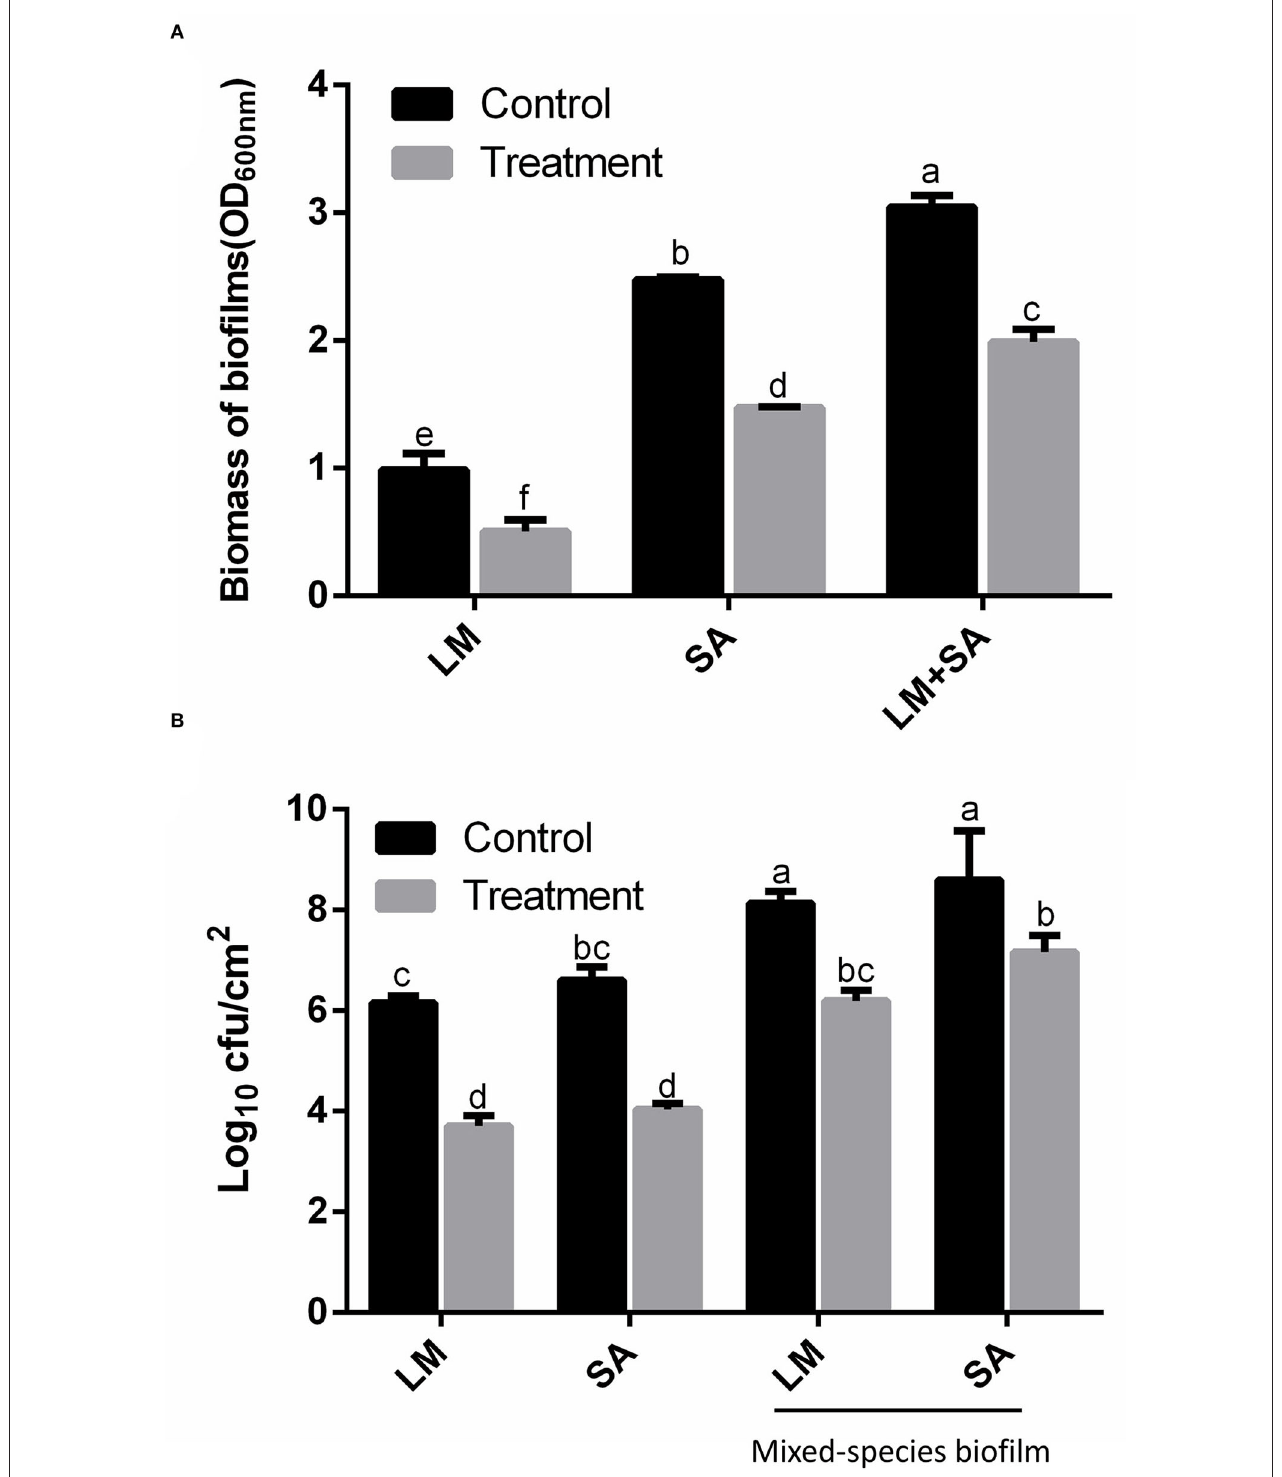
FIGURE 4 | Effect of SAEW on the Staphylococcus aureus , Listeria monocytogenes Scott A, and mixed-species biofilms on the stainless steel surfaces. (A) Crystal violet staining; (B) CFU numbers. The plate counting method was used for the selective agar for Staphylococcus aureus (Baird–Parker agar) and Listeria monocytogenes Scott A (selective oxford agar). LM, Listeria monocytogenes Scott A; SA, Staphylococcus aureus ; LM + SA, mixed-species biofilms of Listeria monocytogenes Scott A and Staphylococcus aureus . Values are expressed as the means ± standard deviations ( n = 3). Different letters represent the significant difference ( p <